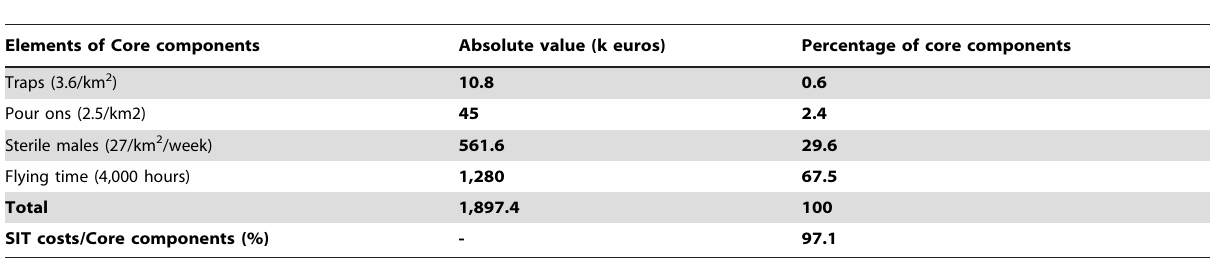
Table 3. Breakdown of core components costs of the tsetse elimination project in the Niayes area. Elements of Core components